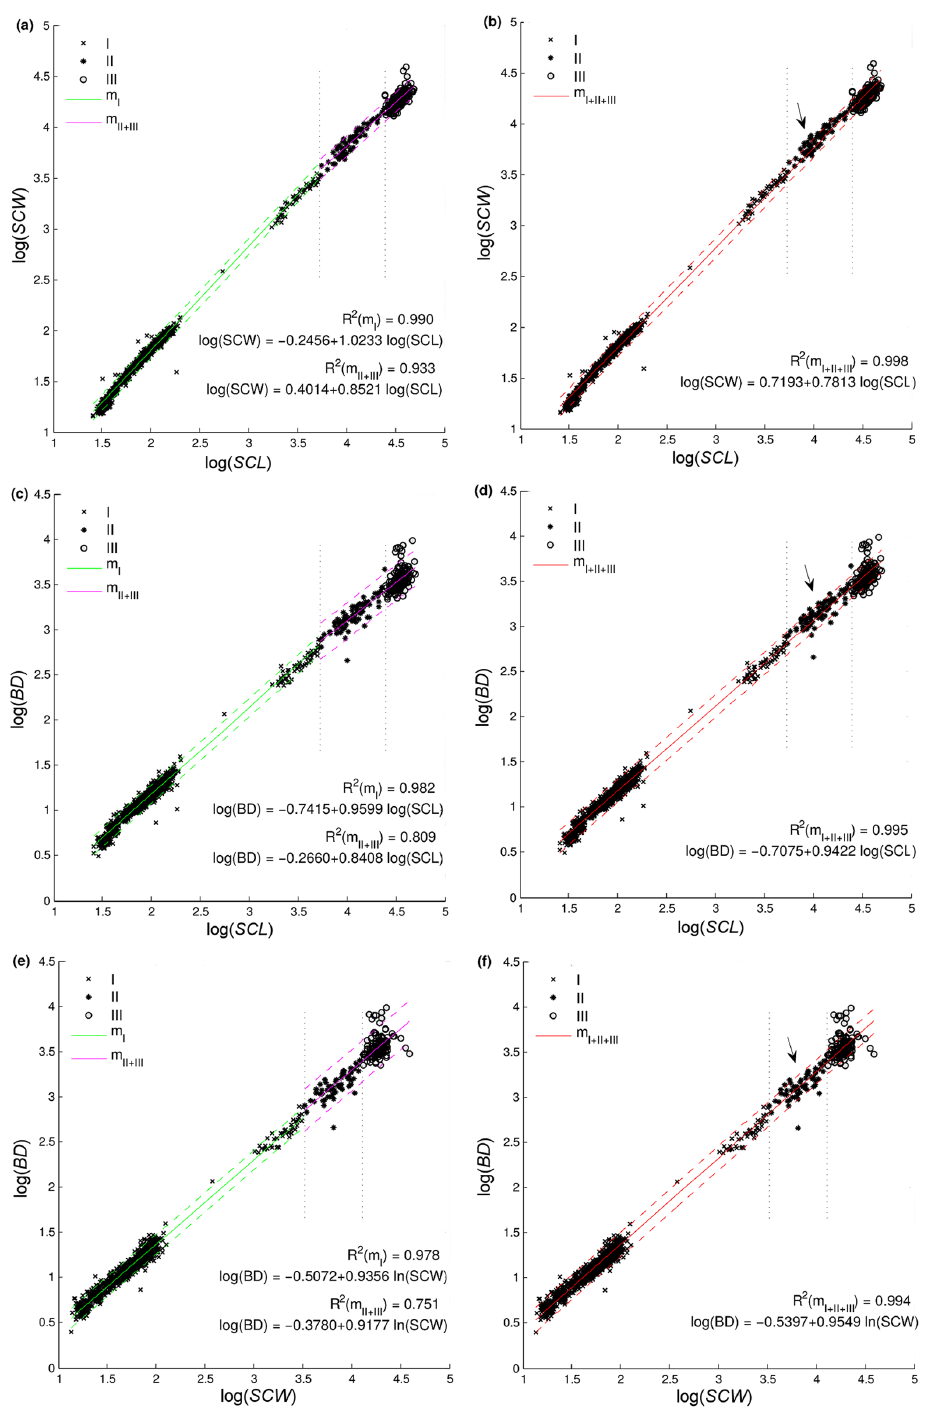
Fig 4. Fit of suggested subset-specific ( ‘ m I ’ , ‘ m II + III ’ , panels (a), (c), (e)), and non-specific ( ‘ m I + II + III ’ , panels (b), (d), (f)) linear scaling models to data. The relationship of log( SCW ) to log( SCL ) is shown in panels (a) and (b), the relationship of log( BD ) to log( SCL ) in panels (c) and (d), and the relationship of log( BD ) to log(SCW) in panels (e) and (f). The recommended regression equations are displayed in the plot, while parameters for remaining equations are provided in Table 5. Dashed lines mark the 95% confidence intervals of the predictions. Black arrows in panels (b), (d), and (f) point to the size range in which predictions are